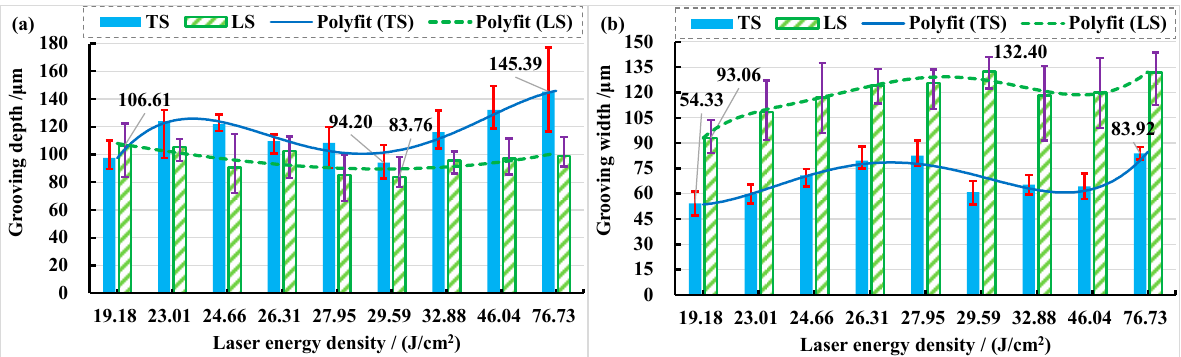
Figure 9. The changes in grooving depth and width in different laser energy densities. ( a ) Grooving depth; ( b ) grooving width.